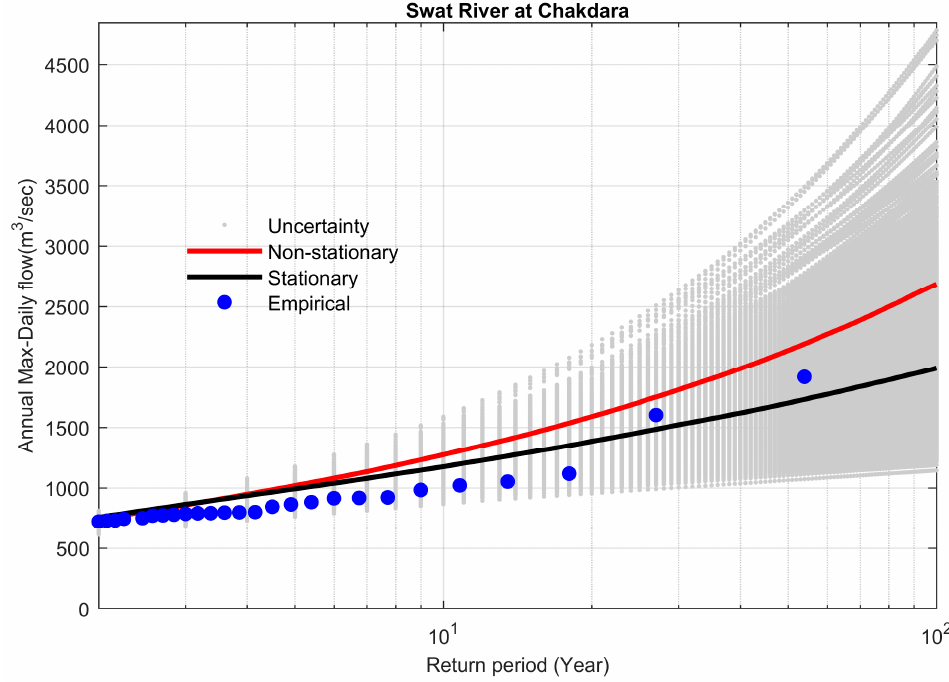
Figure 11. Comparison between non-stationary and stationary FFCs at site 9, along with non- stationary uncertainty bounds for the year 2009.